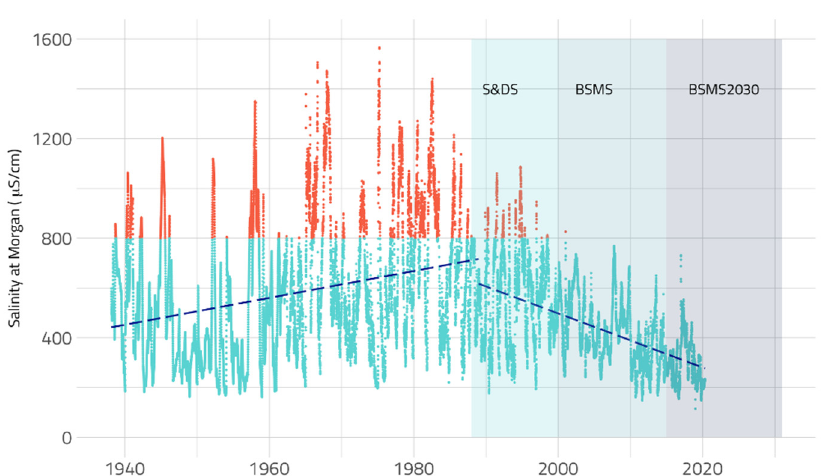
Figure 3. Daily salinity at Morgan on the River Murray showing the times salinity exceeded 800 EC (the target at Morgan) (red) and times salinity was less than 800 EC (green). Note the linear regression plot (blue line) which shows the increase in salinity to around 1988 and then a gradual decrease due to the introduction of salinity management actions and more recently to a drier climate (Source: data supplied by the MDBA; plot provided by Rod Marsh).